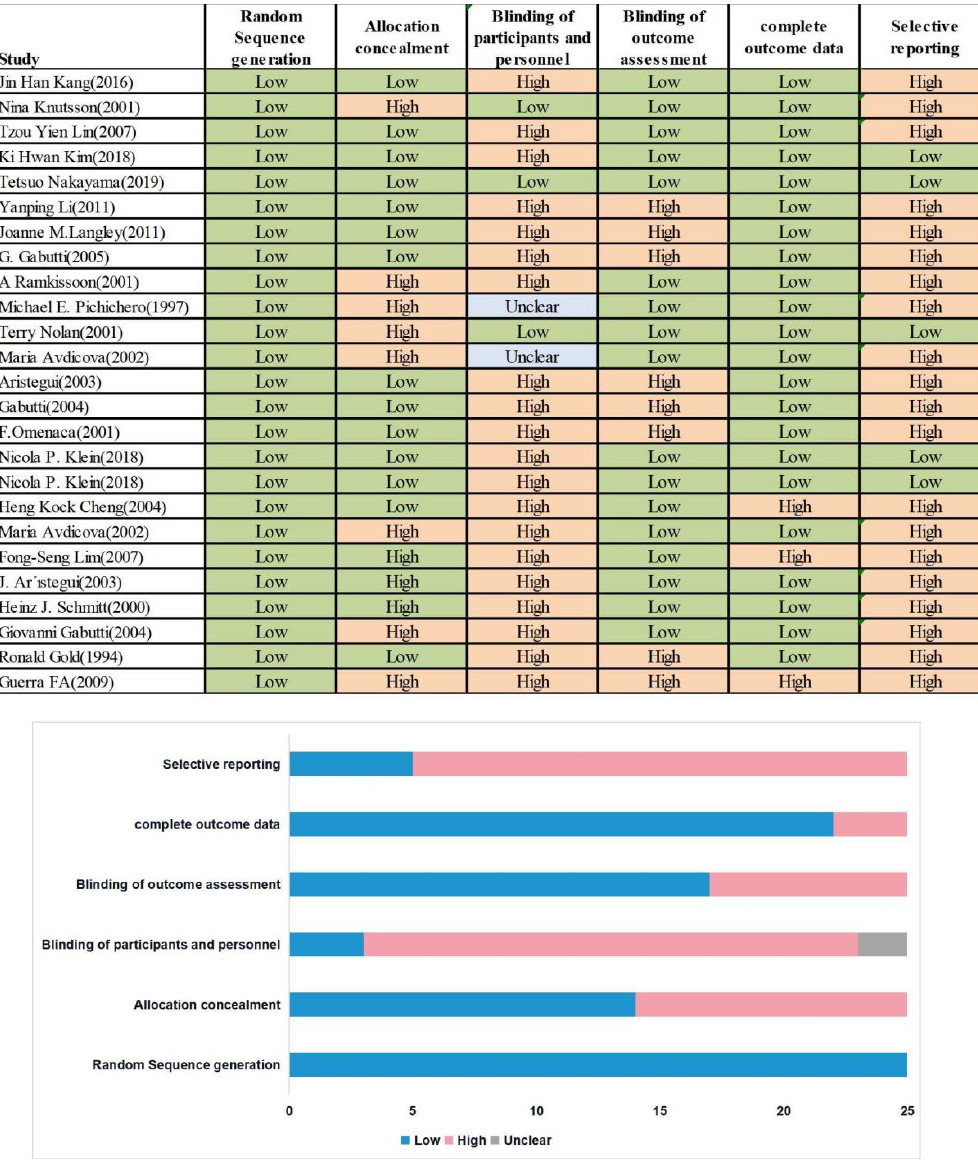
Figure 2. Quality Assessment of included studies.